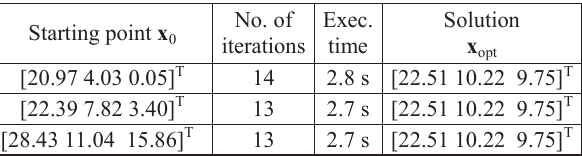
Table. 1. Results of optimisation. Starting point x 0